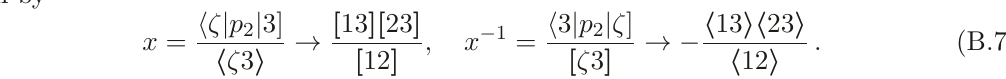
( m 3 /E 3 ). The SMEFT coefficients were omitted for O